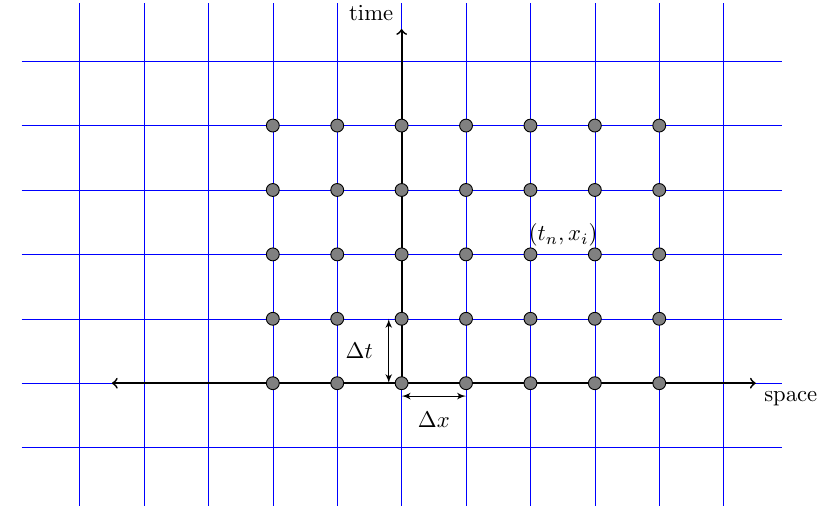
Figure 1. Finite difference grid for one-dimensional